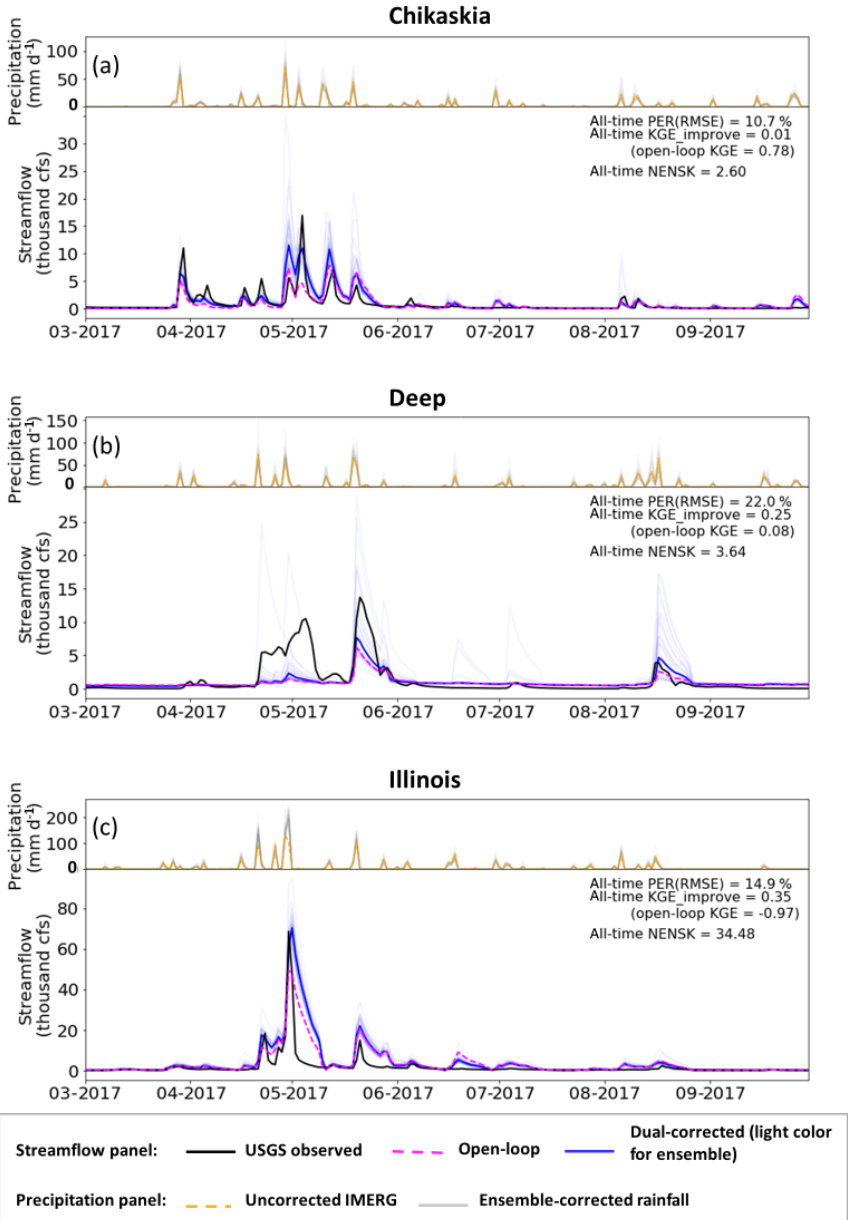
Figure 7. Same as Fig. 6 but with calibrated VIC model